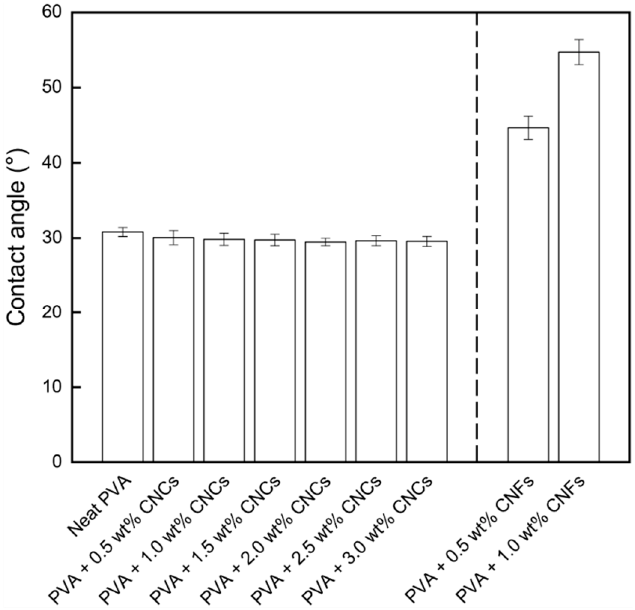
Figure 6. Contact angles of the PVA + CNC/CNF nanocomposite films.